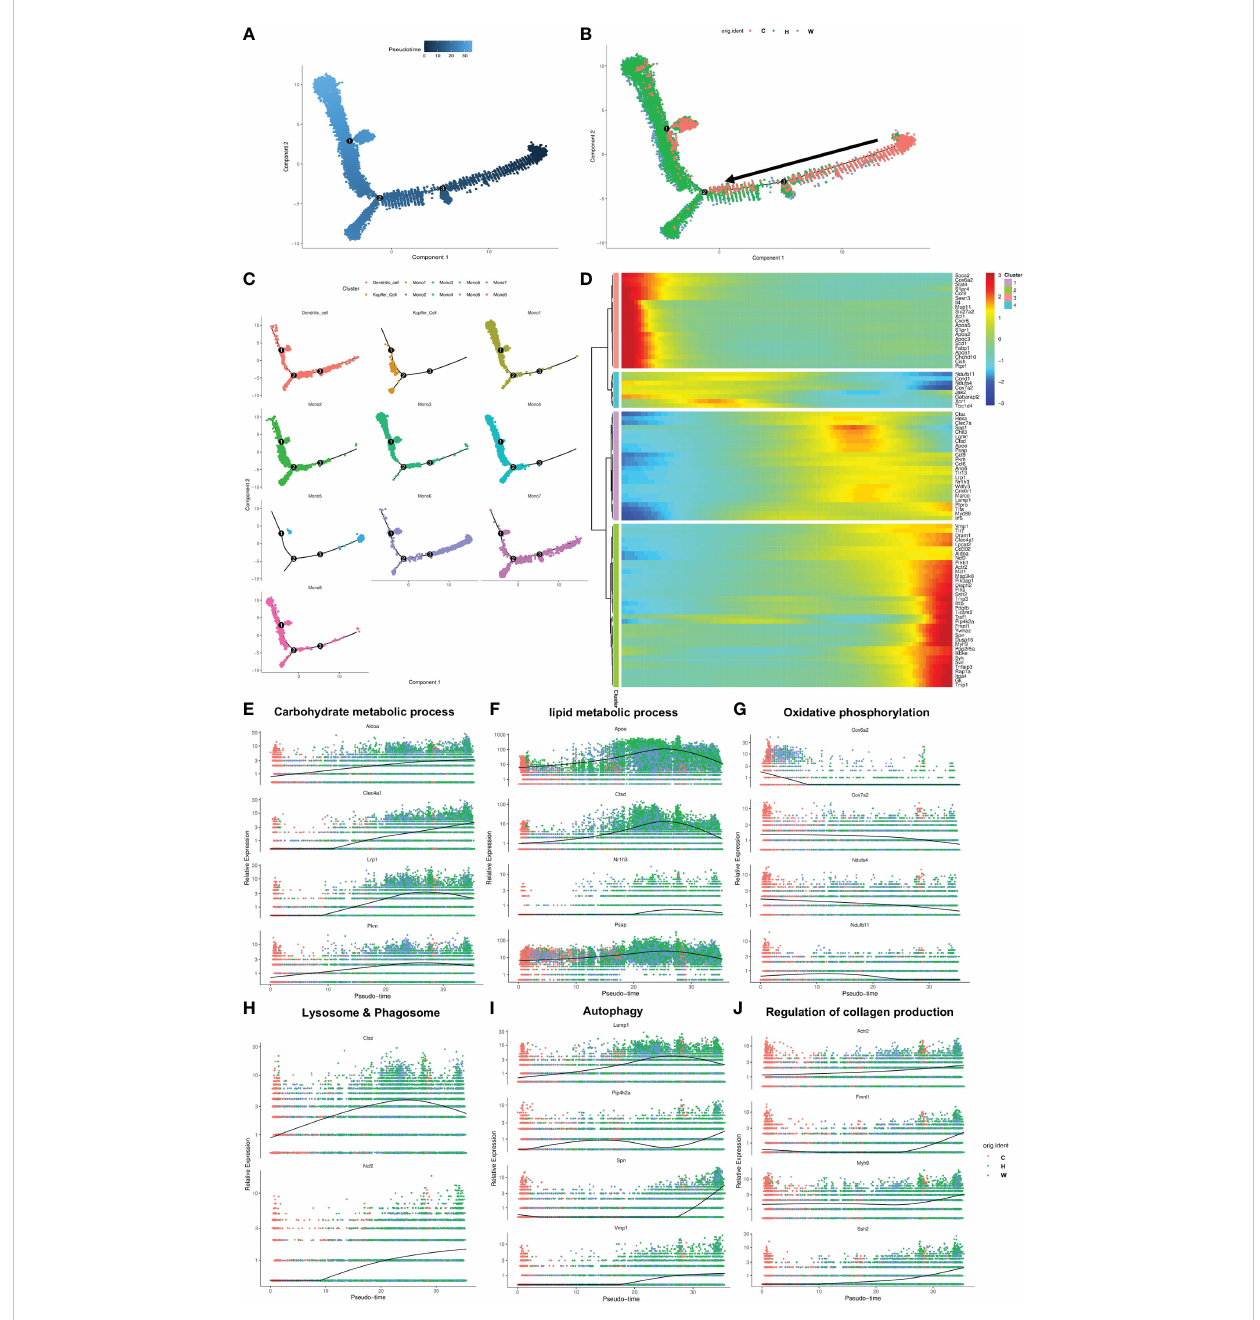
FIGURE 4 The transition trajectory and regulatory networks of cells in the MMD system. (A, B) Pseudotime-ordered analysis of cells in the MMD system from control and NASH mice. (C) Pseudotime plot showing the transition trajectory of Kupffer cells, DCs and 8 monocytes. (D) Heatmap showing the dynamic changes in gene expression along the pseudotime axis. (E-J) Characteristic genes in the select signaling pathway that are differentially expressed across the pseudotime of cells in the MMD system. ps: C, control mice; H, HFD+F+CCl4 mice; W, WFD+F+CCl4